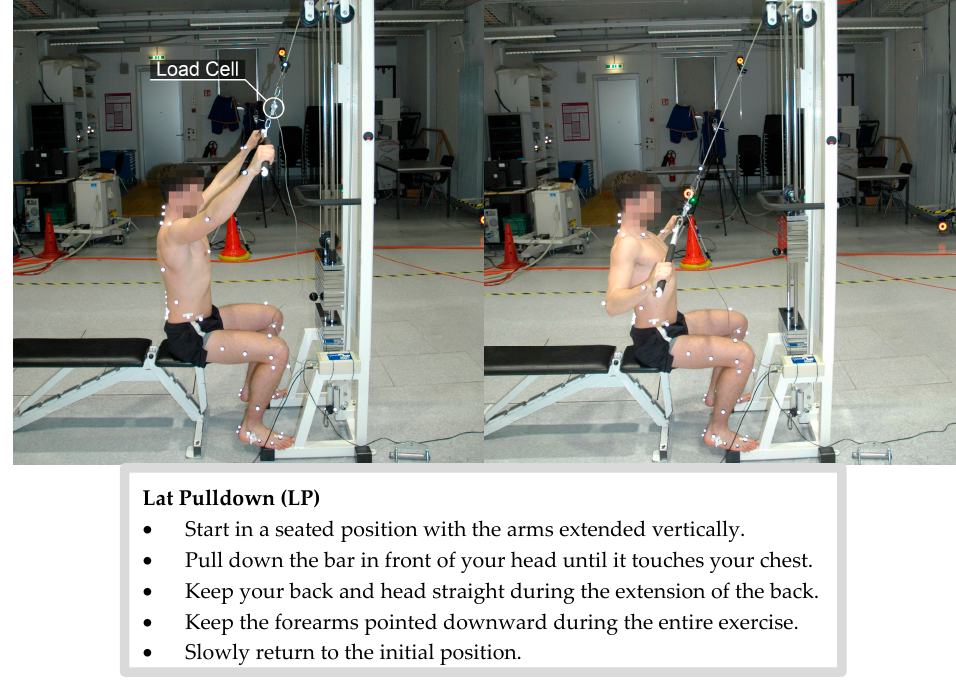
Figure A1. Experimental setup and execution of the lat pulldown. The subject with a complete “IfB marker set” is shown List et al. 2013 [31].